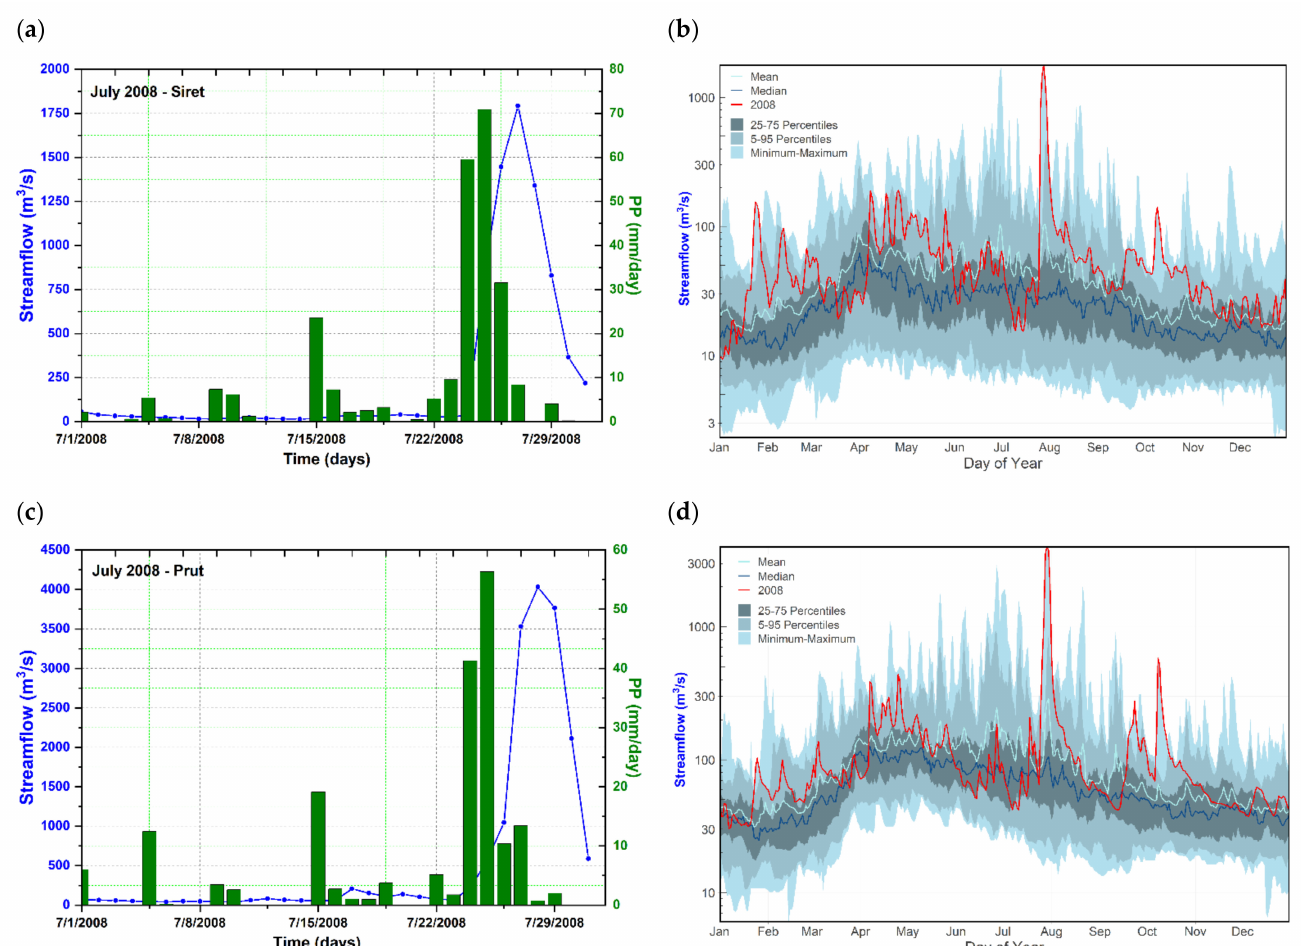
Figure 3. ( a ) Daily streamflow at Lespezi gauging station situated on the Siret River (blue line) and the precipitation amount at R ă d ă ut i meteorological station (green bars) for the period 1 July–31 July2008; ( b ) The evolution of the flood peak in , July 2008 (red line) at Lespezi gauging station compared to the daily streamflow pattern on an annual basis (blue shaded line); ( c ) Daily streamflow at R ă d ă ut i-Prut gauging station situated on the Prut River (blue line) and the daily precipitation , amount at Darabani meteorological station (green bars) for the period 1 July–31 July 2008 and ( d ) The evolution of the flood peak in July 2008 (red line) at R ă d ă ut i-Prut gauging station compared to the daily streamflow pattern on an annual basis , (blue shaded area). For the location of the gauging and meteorological stations; see Figure 1. The period 1981–2000 was used to compute the daily streamflow climatology in ( b , d